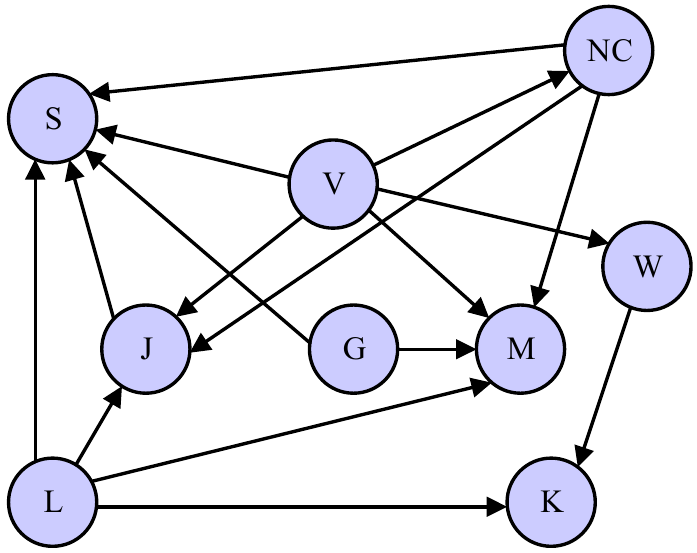
Figure 4. Digraph of the machining center component association relationship.